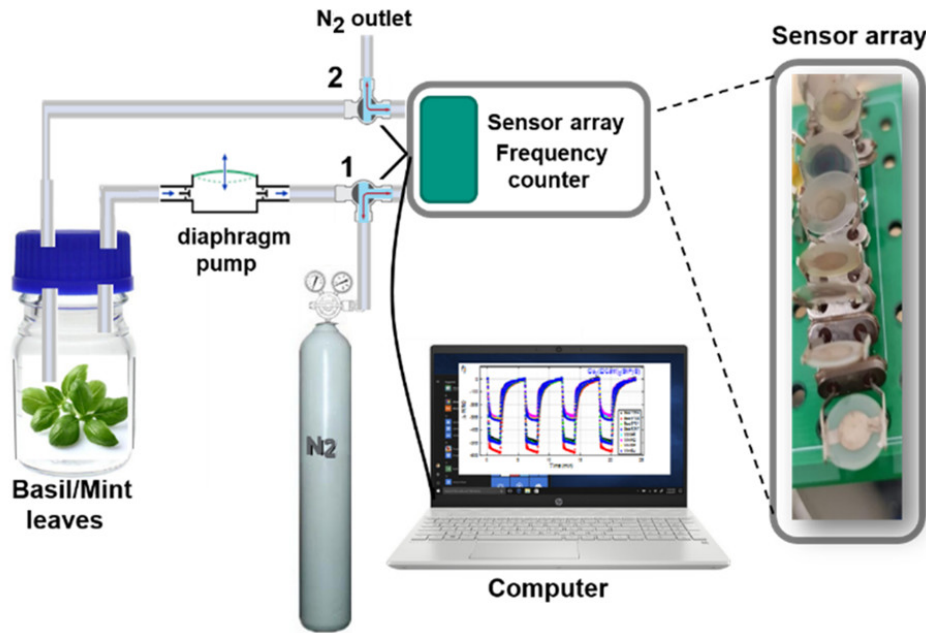
Figure 2. A schematic view of the working principle of the six-channel low-cost homemade portable e-Nose system used for discrimination of scents from basil/mint leaves.